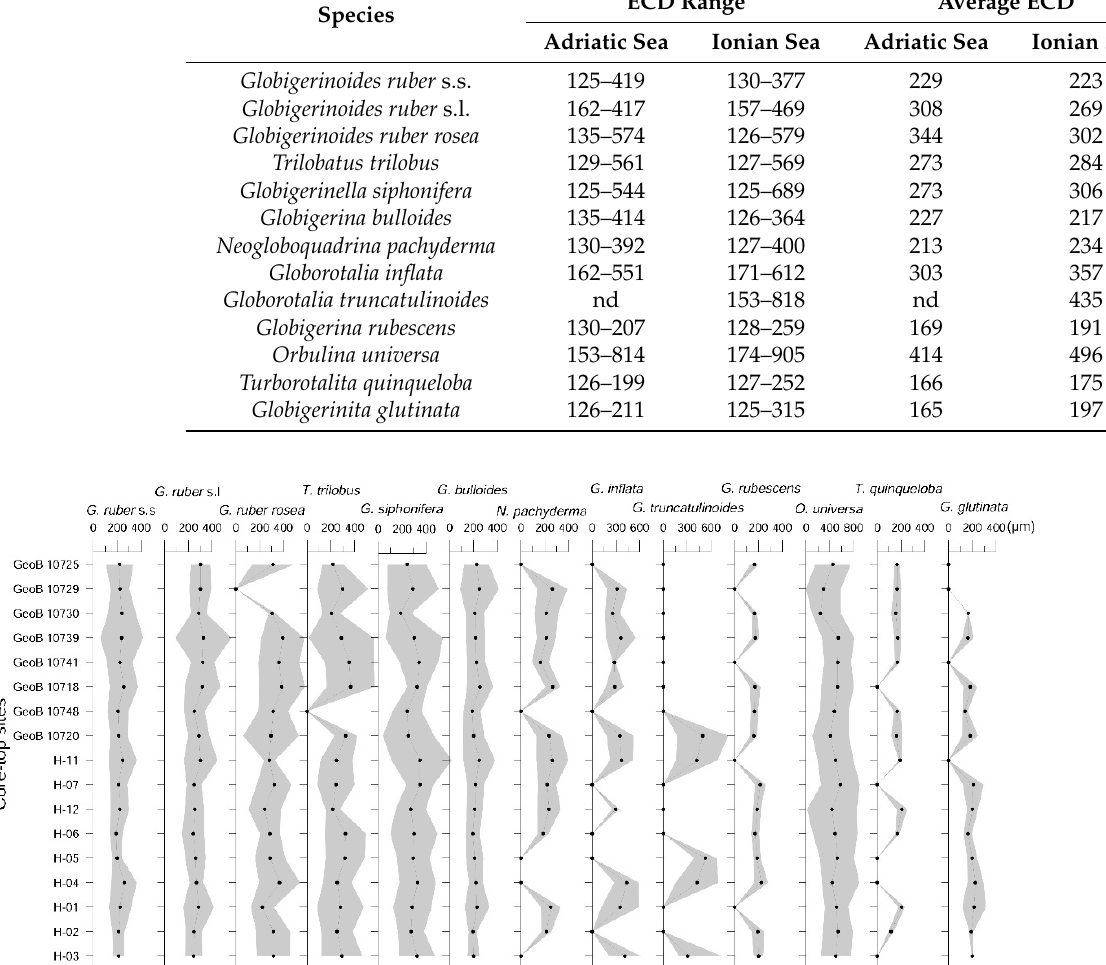
Figure 3. Average population size of the planktonic foraminifera species identified together with their overall population size. The gray shaded areas denote one standard deviation. The labels in the vertical axis are representative of the core-top locations presented in Table 1.